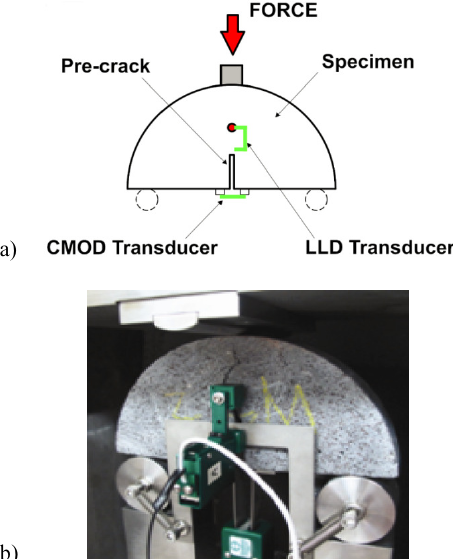
Fig. 2. Disc Compact Tension test (DCT): a) DCT schematic; b) DCT picture (with additional CMOD mounted on the front